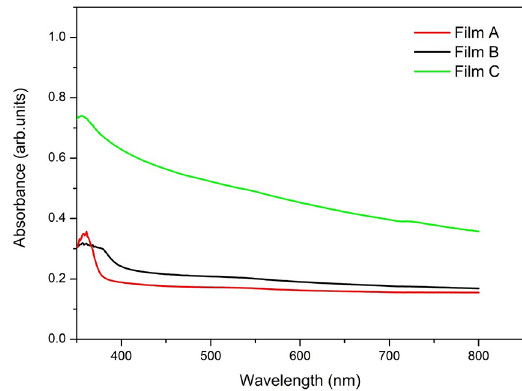
Figure 8. Absorbance analysis of the deposited ZnO thin films